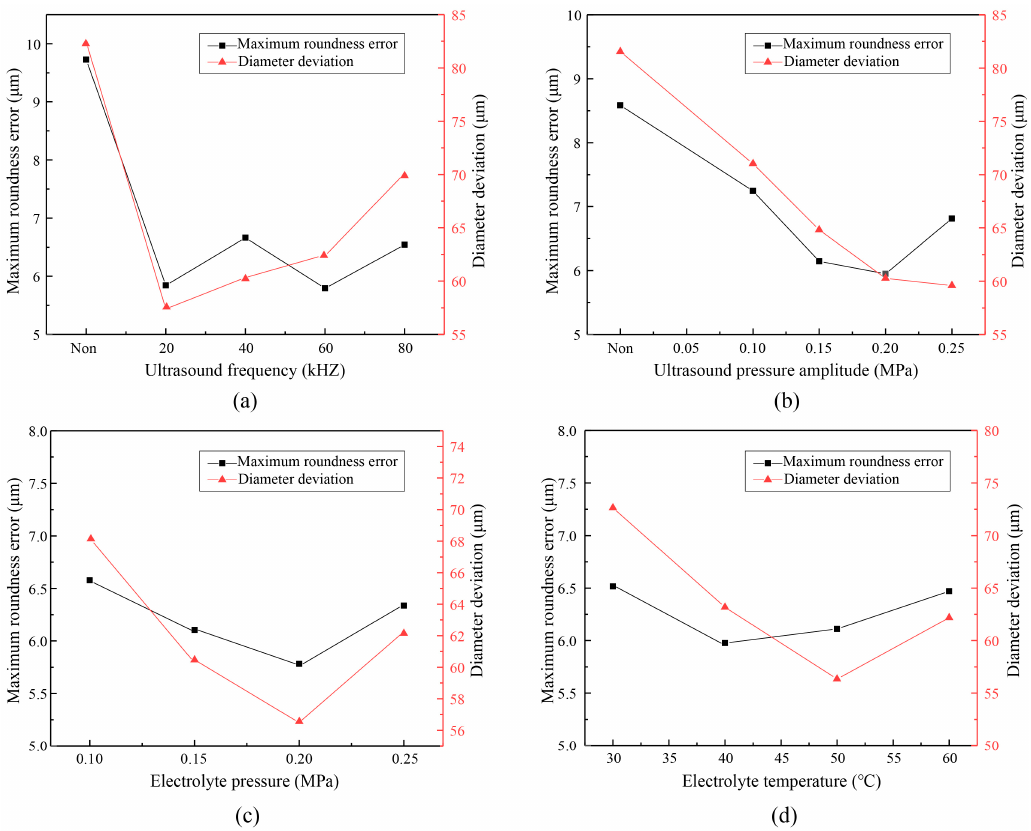
Figure 10. Experimental results with di ff erent parameters. ( a ) Diameter deviation and roundness error with ultrasound frequency; ( b ) Diameter deviation and roundness error with ultrasound pressure amplitude; ( c ) Diameter deviation and roundness error with electrolyte pressure; ( d ) Diameter deviation and roundness error with electrolyte temperature. Table 2. The values of all parameters adopted for Figure